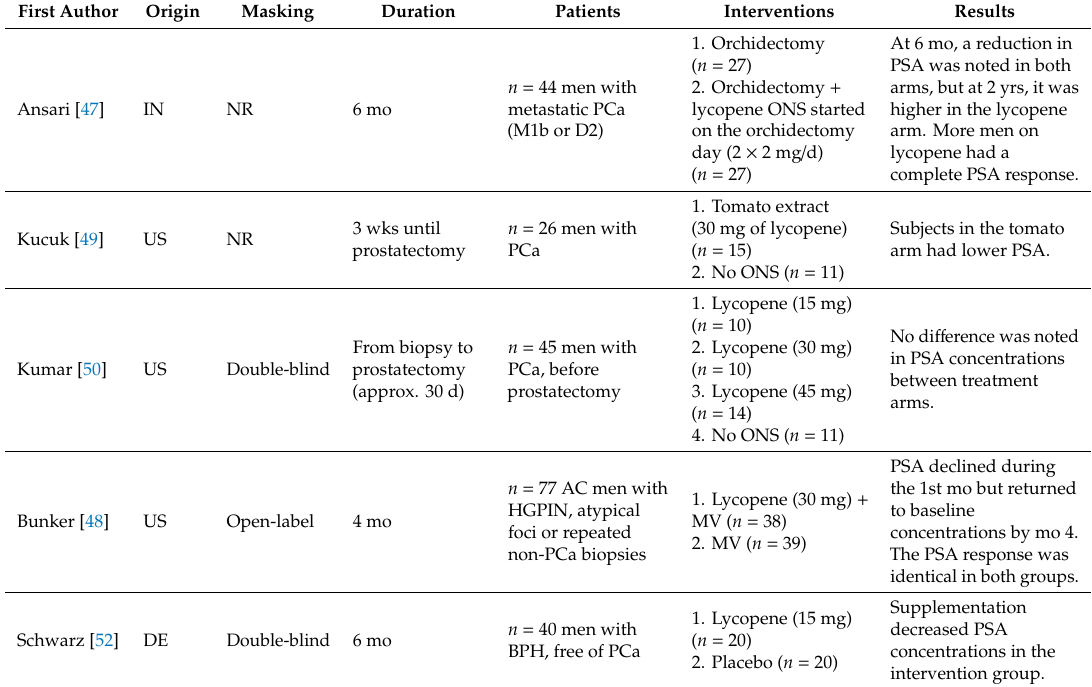
Table 1. RCTs examining the e ff ect of lycopene ONS, or the consumption of tomato-products on the PSA concentrations among men with PCa, increased PCa risk, or